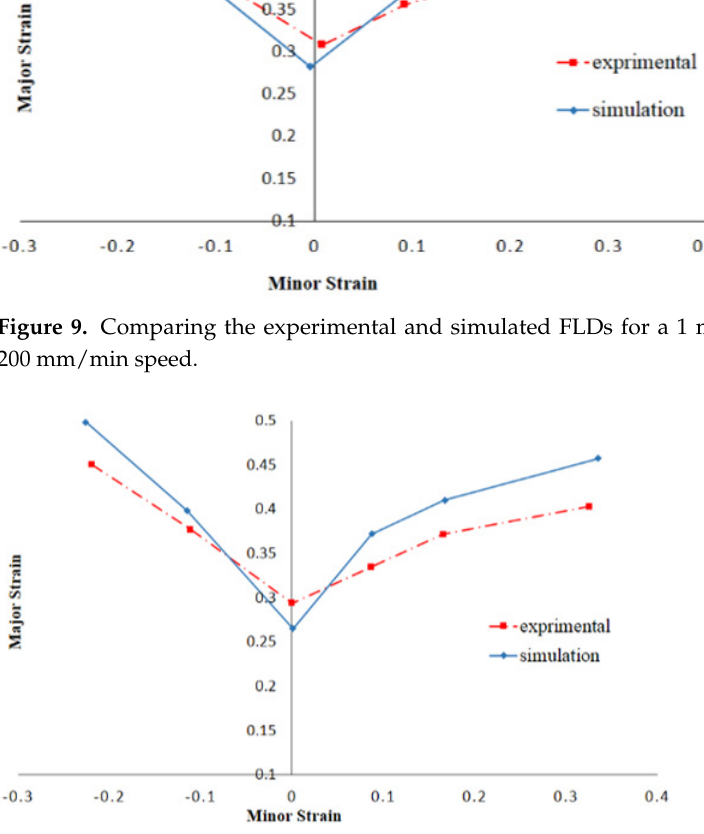
Figure 10. Comparing the experimental and simulated FLDs for a 3 mm-thick AA 6061 sheet at 20 mm/min speed.